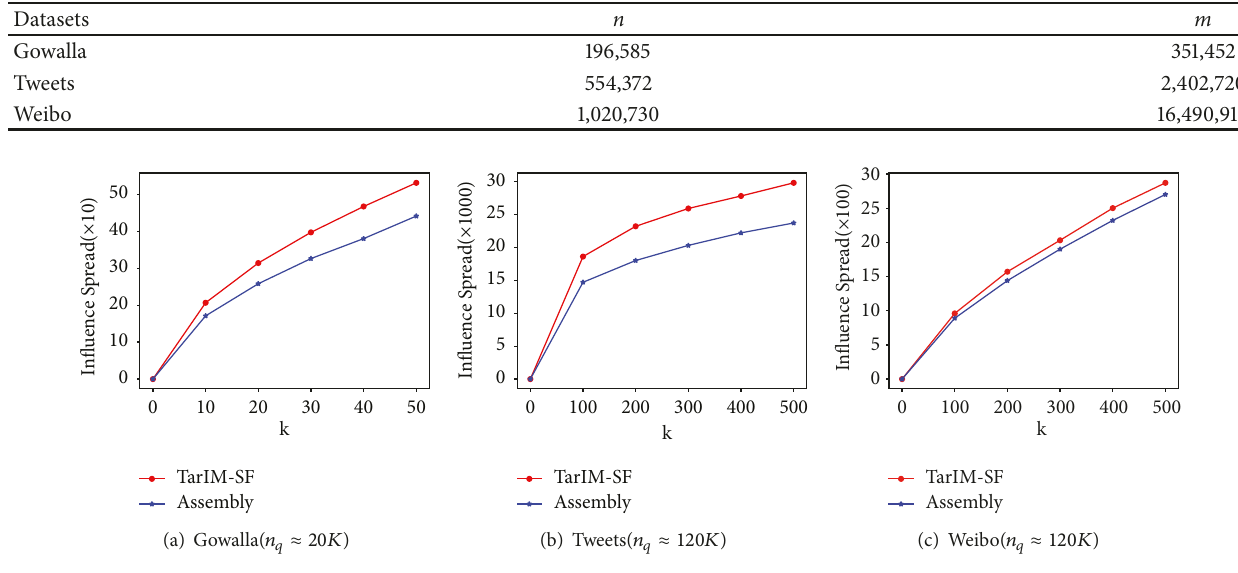
Figure 4: Influence spread under WC model.